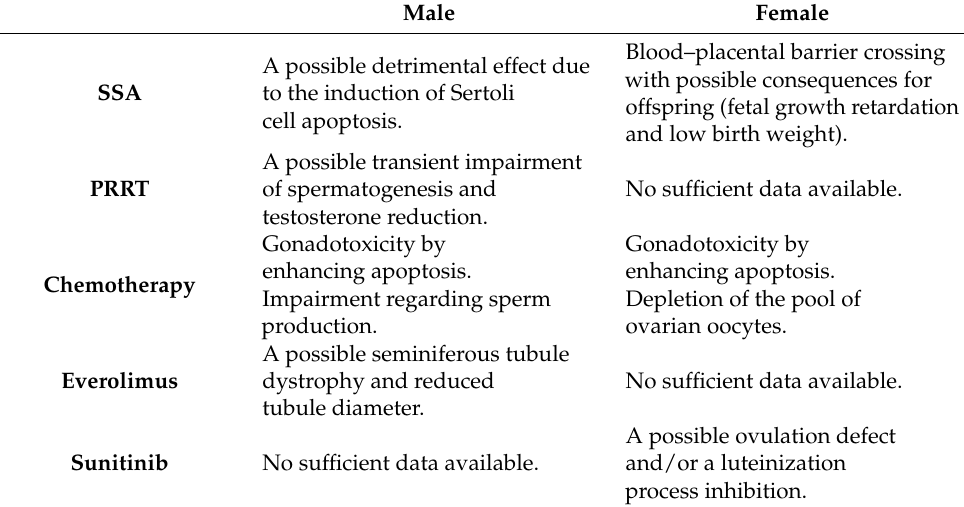
Table 2. The effect of neuroendocrine neoplasm treatment on male and female fertility. Male